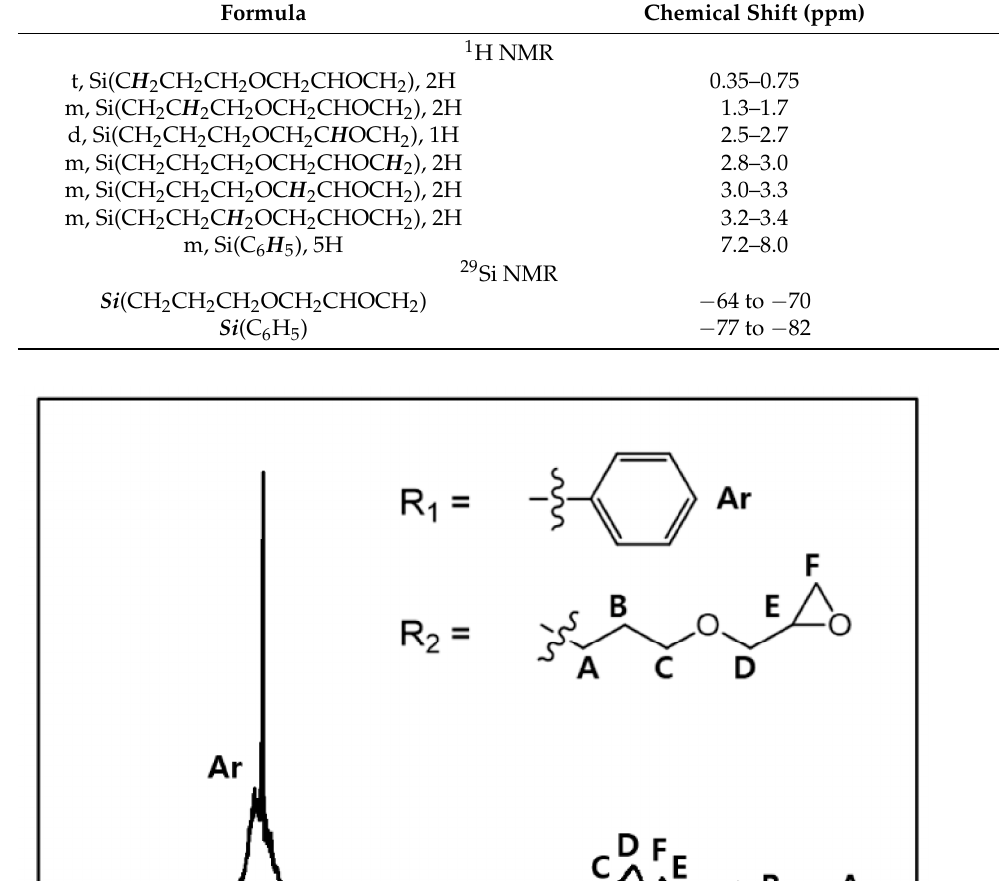
Table 1. Assignments of 1 H and 29 Si NMR for the ladder-structured poly(phenyl-co-glycidoxypropyl) silsesquioxane (LSGSQ64).